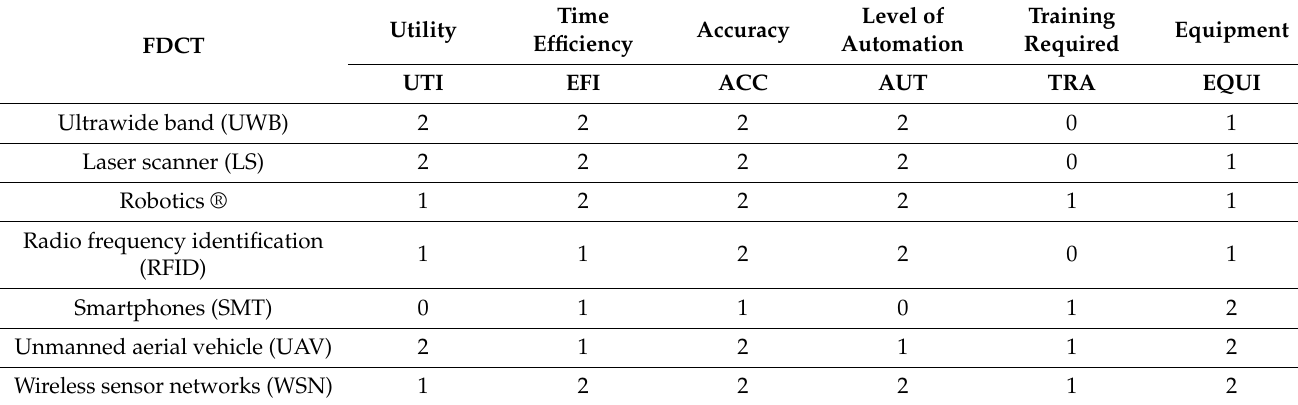
Table 12. Performance matrix of digital tools for in situ data acquisition.